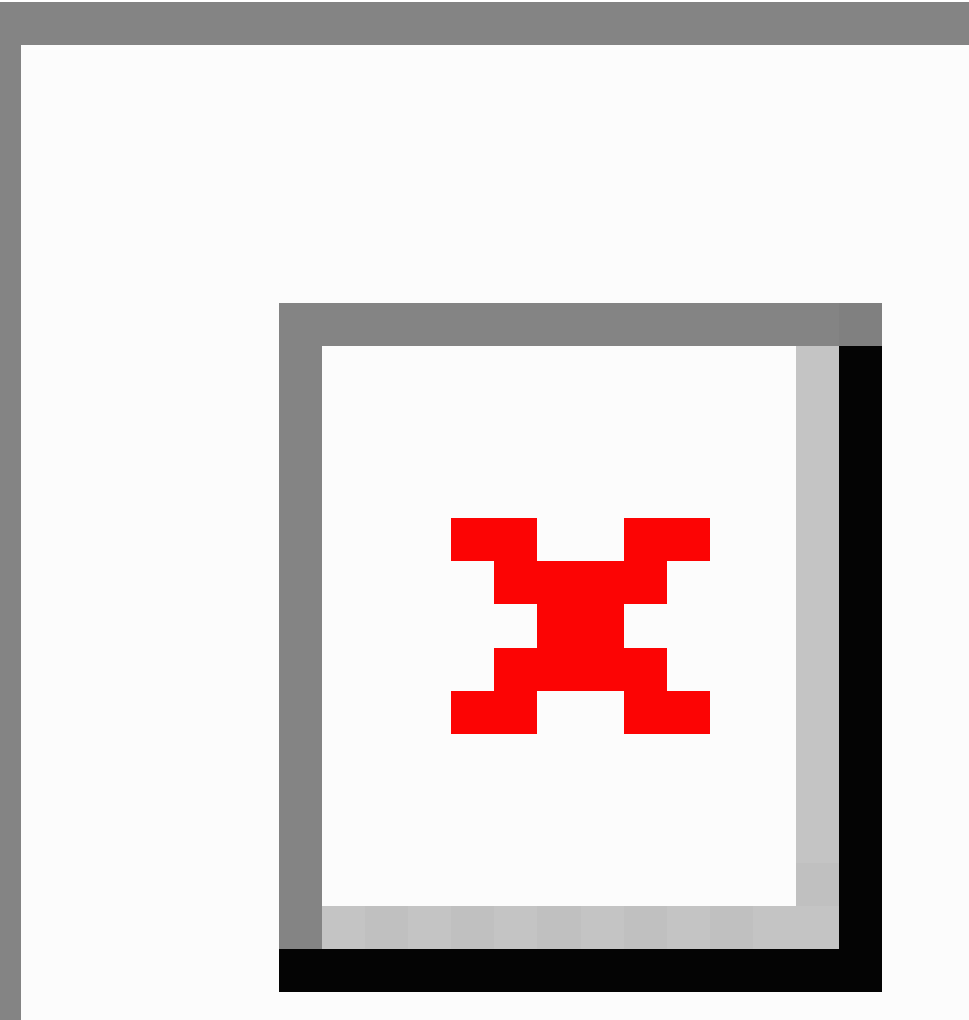
Figure 2. The process in a real-world trial. The first stage was activity level estimation. The second stage was AAEI estimation. The sensor data translated to activity level in first stage and then converted to AAEI in second